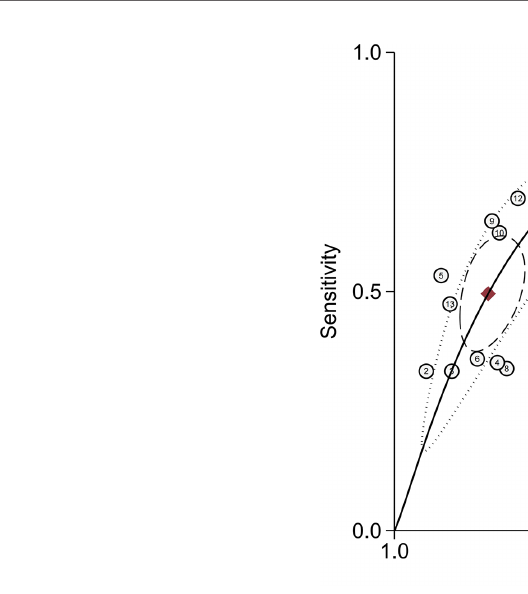
FIGURE 4 | Summary receiver operating characteristic curves of peritumoral enhancement on the arterial